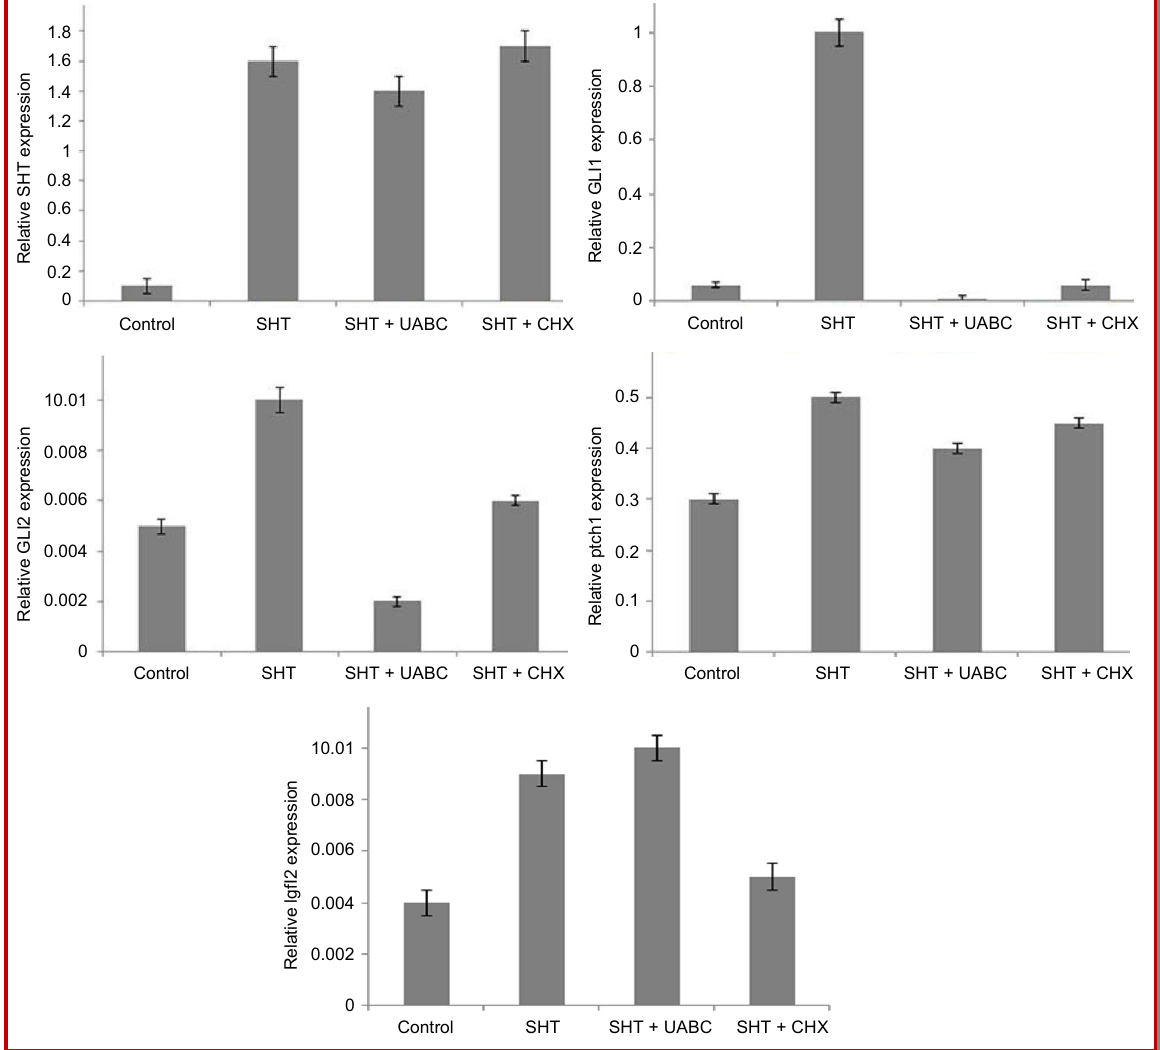
Figure 6: Hedgehog activation assay. The NIH-3T3 cells were transiently transfected with 1 μ g sonic hedgehog (Shh) expression plasmid. For the inhibition of hedgehog signalling, cells were additionally exposed to UABC and 10 μ M cyclopamine (CHX.) after 48 hours transfection. Expression of the murine genes SHT, Gli1, Gli2, Ptch1, and Igf2 was determined after an incubation period of 48 hours using quantitative real-time PCR in relation to the house-keeping gene TBP as a